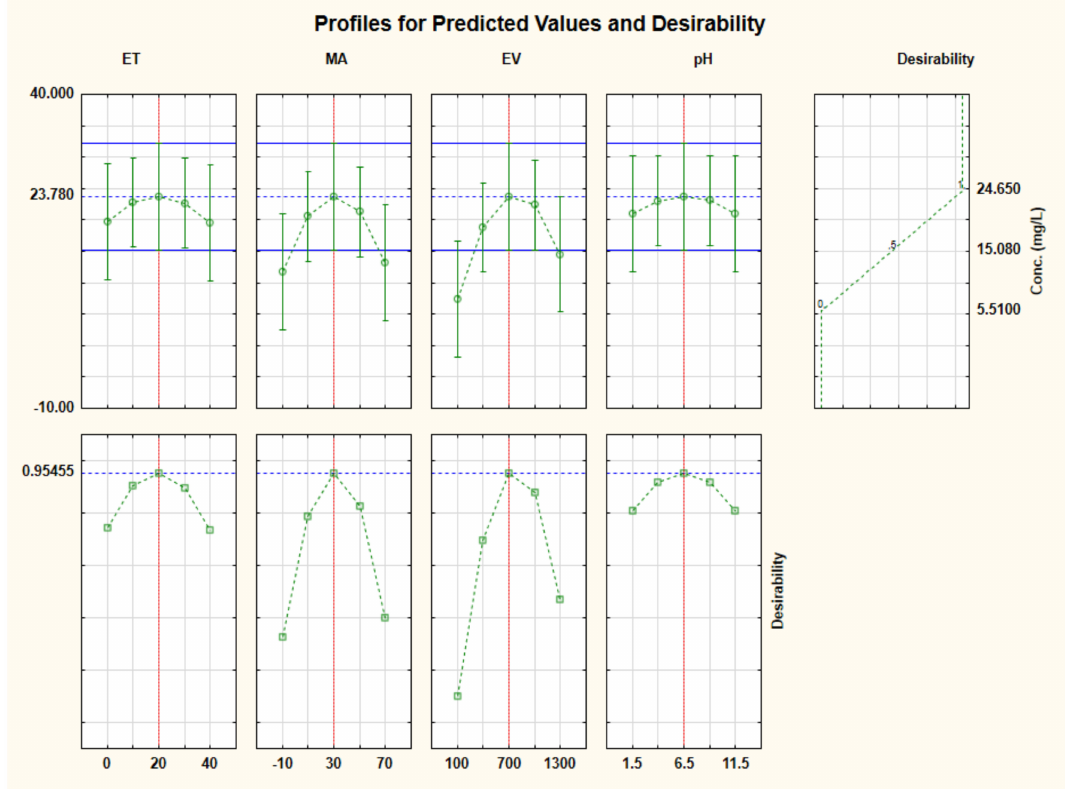
Figure 7. Desirability profiles with predicted values for the investigated factors affecting the extraction of trenbolone. Figure 8